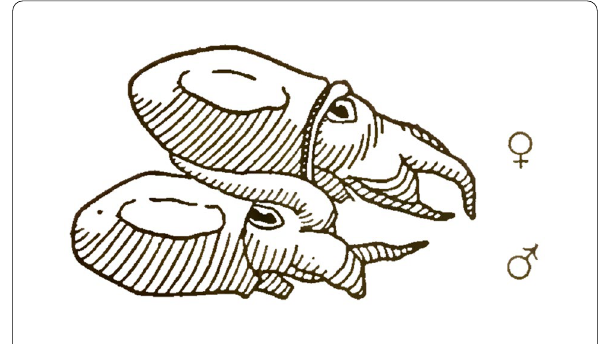
Fig. 3 Mating in Sepiola atlantica (after Levy,